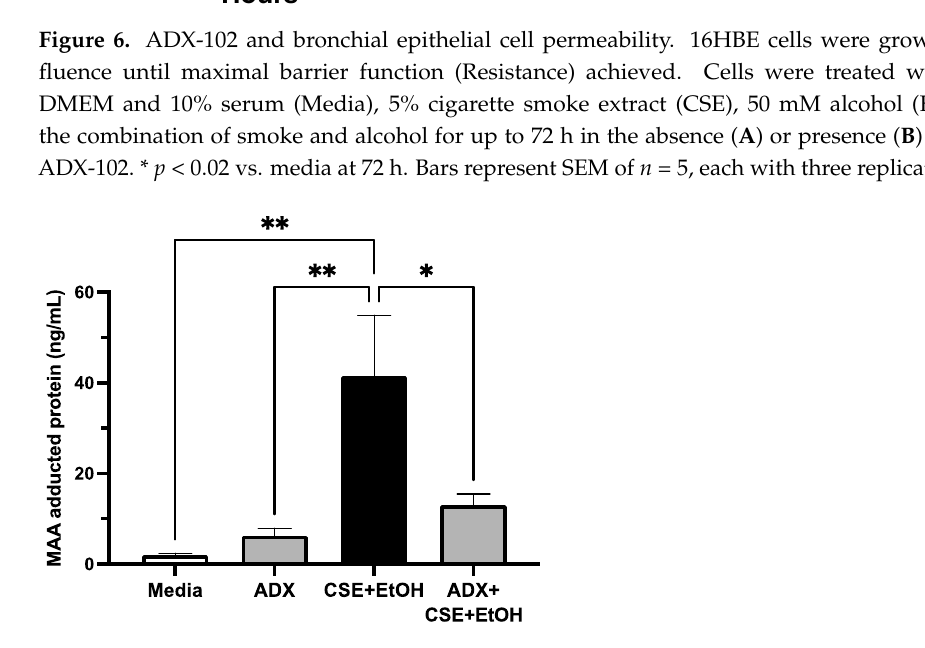
Figure 7. ADX-102 and MAA adduct formation. 16HBE cells were grown to confluence in 60 mm culture dishes. Cells were treated with either M-199+10% serum (Media) or a combination of 5% cigarette smoke extract (CSE) and 50 mM alcohol (EtOH) for 72 h in the absence or presence of 10 µM ADX-102. * p <0.04 and ** p < 0.003 at 72 h. Bars represent SEM of n = 6.